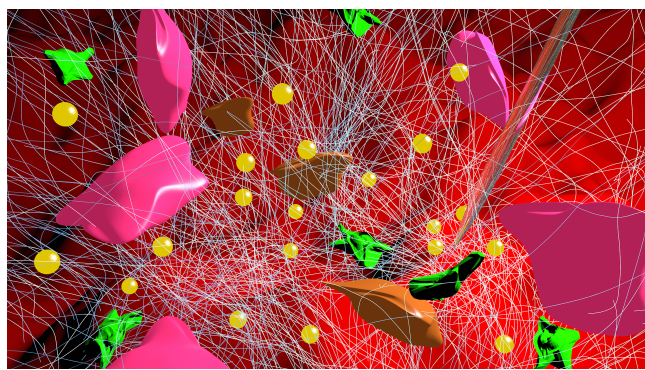
Figure 5. Following cardiac ischemic injury, lack of blood supply results in cardiomyocyte apoptosis (brown). After an inflammatory response, myofibroblasts and macrophages (green) migrate towards the injured area leading to fibrosis thus creating scar tissue (white). When scaffolds are applied to the injured area (in this case by injection via syringe (clear)), exploiting the superior material properties of nanomaterials such as gold nanoparticles (yellow) have demonstrated reduced scarring and often slowed left ventricular remodeling. The (pink) cardiomyocytes in this figure are shown to regenerate along the site of scaffold